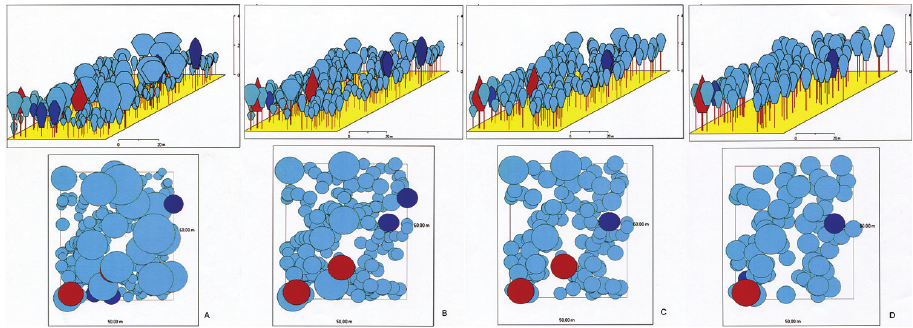
Figure 2. Growth simulation model for the Jeleni Bucina study site: current state ( A ) and future forest development for the periods of 25 years ( B ), 50 years ( C ), 80 years ( D ) (light blue: Fagus sylvatica , dark blue: Acer pseudoplatanus , red: Picea abies ).